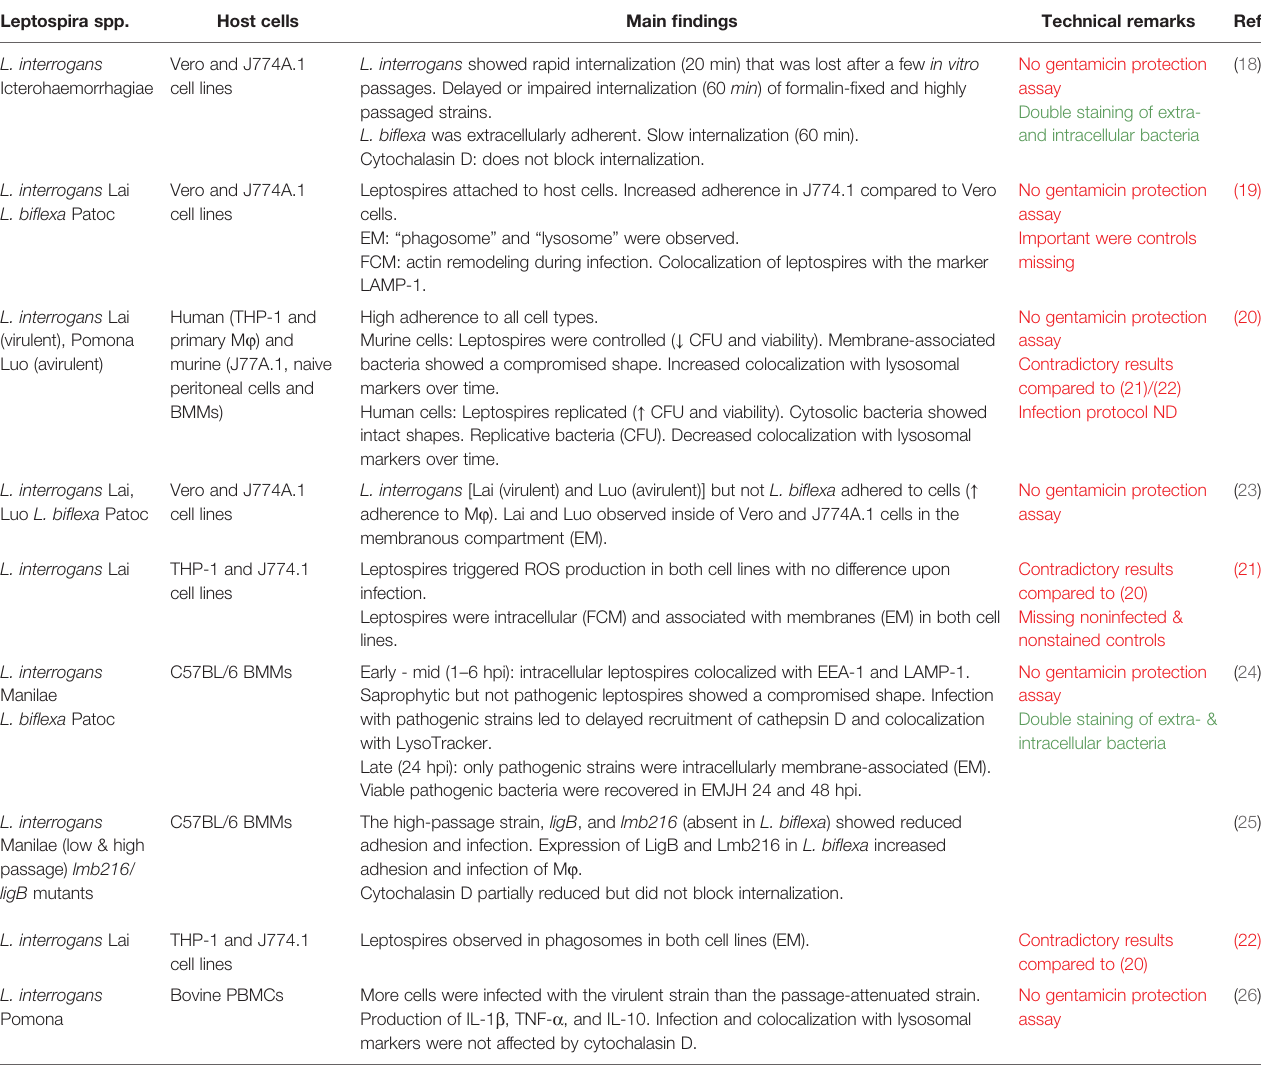
TABLE 2 | Intracellular localization and fate of leptospires. Leptospira